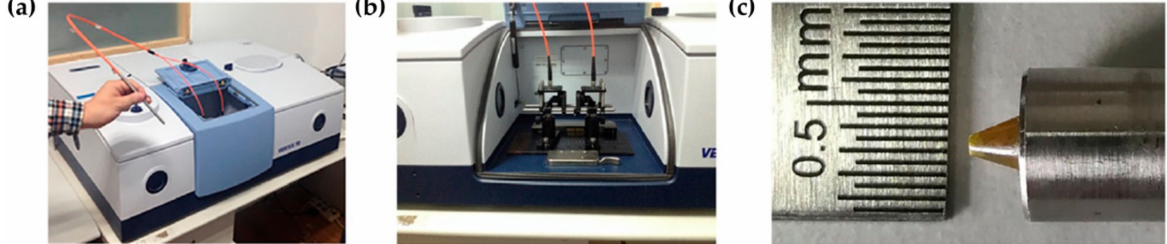
Figure 10. ( a ) Photo of the ATR-HOF probe developed by Zhao et al.; ( b ) fixing-coupling equipment used to attach the probe to the spectrometer and ( c ) end of the ATR-HOF crystal probe